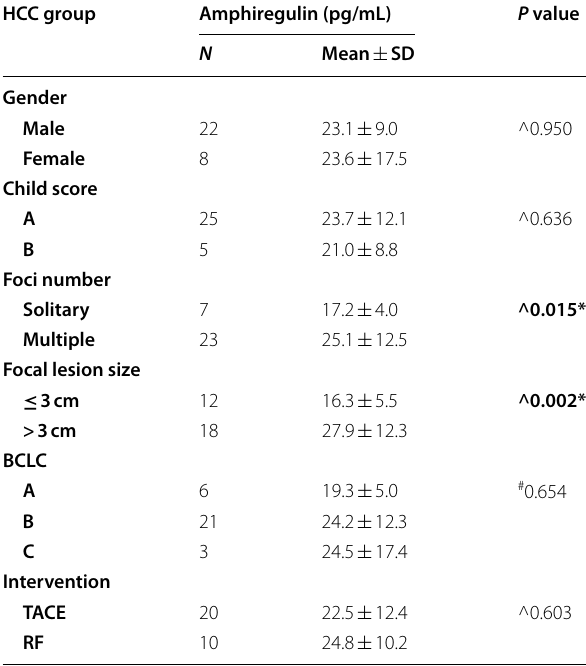
Table 3 Comparison between baseline amphiregulin serum level (pg/mL) and other studied parameters among the HCC group